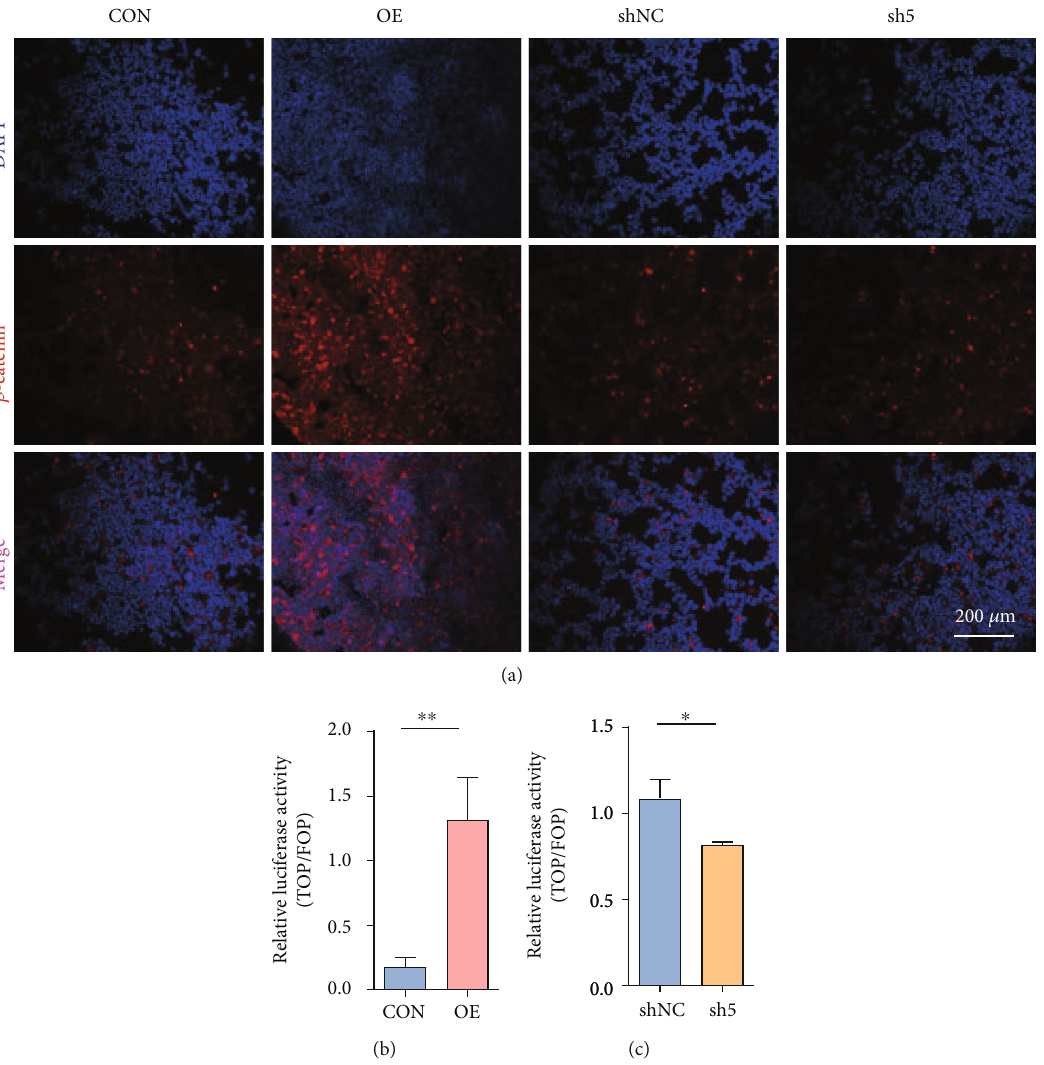
Figure 4: ANTXR1 activates the Wnt/ β -catenin signaling pathway by promoting β -catenin into the nucleus. (a) The expression of β -catenin in K562 cells after overexpression or knockdown of ANTXR1 was detected by immuno fl uorescence with a confocal laser scanning microscope. The color “ red ” represents β -catenin, and “ blue ” represents nuclei stained by DAPI. The merged images indicate the localization of β -catenin in both the nuclei and cytoplasm. (b, c) The TOP-/FOP- fl ash luciferase assay shows the activity of the Wnt/ β -catenin signaling pathway in 293T cells overexpressing or knocking down the ANTXR1 gene. Experiments n = 3 . The error bar represents the SD. ∗ P < 0 : 05 and ∗∗ P < 0 : 01 . NC designates the negative